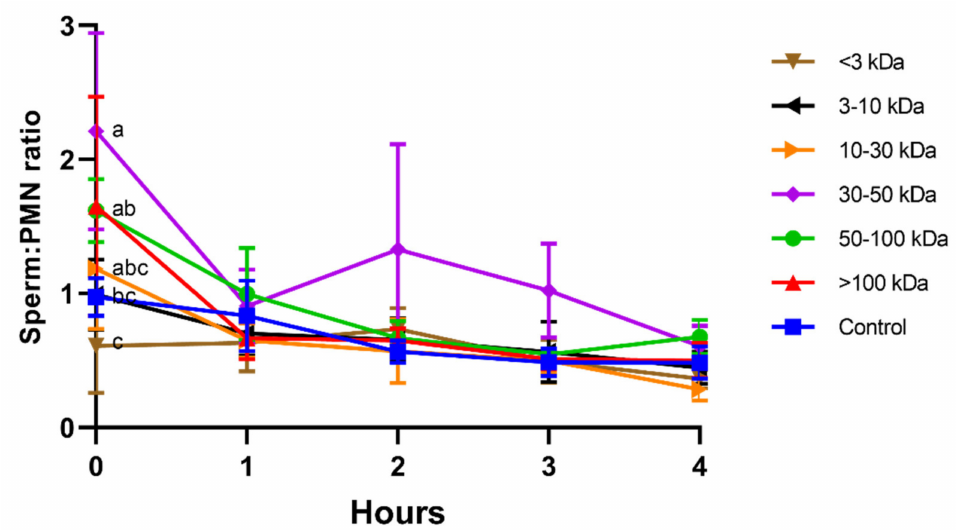
Figure 2. Sperm:PMN ratios (number of spermatozoa attached to one PMN) for different seminal plasma fractions and throughout incubation at 38 ◦ C for 4 h. Different superscripts (a–c) mean significant differences between seminal plasma fractions within a given time point ( p ≤ 0.05). Data are shown as mean ± SD for 12 independent